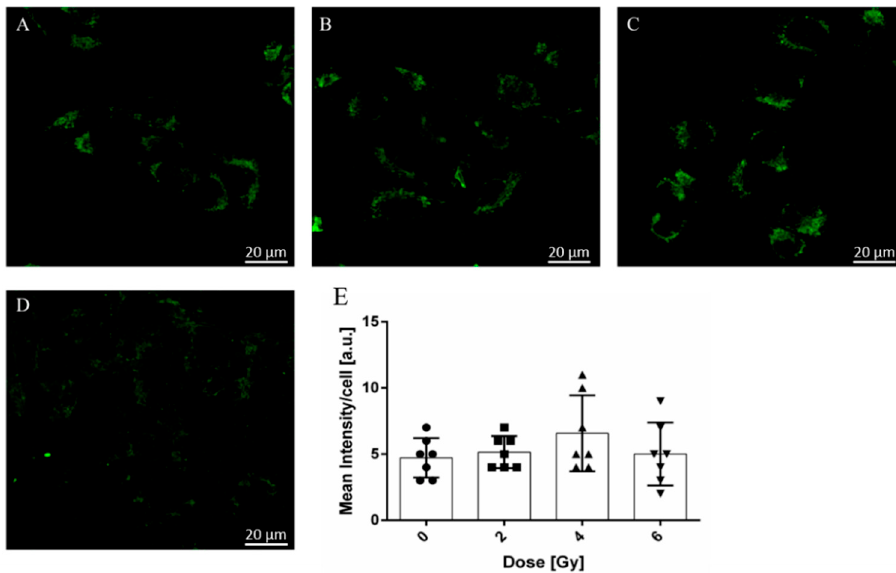
Figure 4. Mitochondrial morphological changes in A375 cells after X-ray radiation: ( A ) not-exposed ( • ) vs. exposed cells to ( B ) 2 Gy ( ■ ), ( C ) 4 Gy ( ▲ ) and ( D ) 6 Gy ( ▼ ). ( E ) Quantification of each cell fluorescence from A–D by ImageJ (the number of symbols for each dose represents the number of cells).